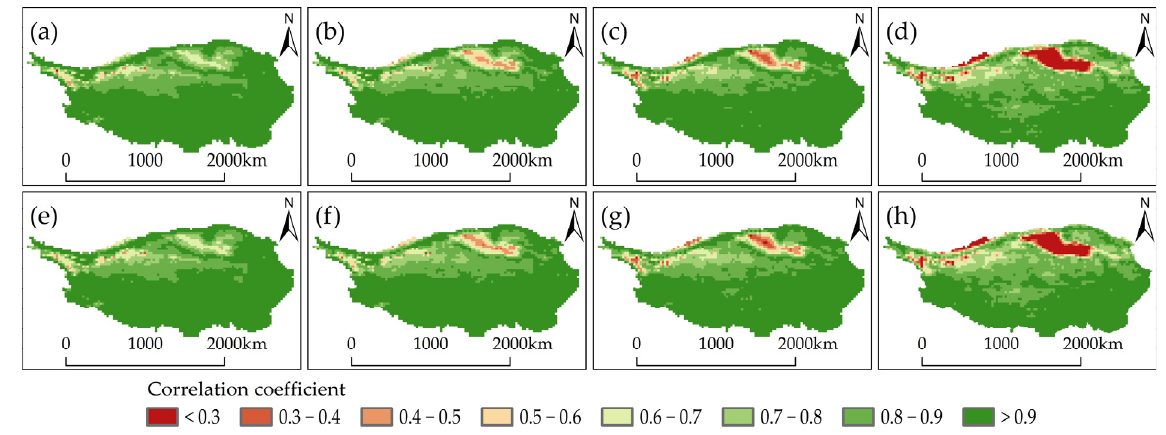
Figure 14. Correlations of three drought indices under different climate scenarios: PA index and SPEI index correlation under the ( a ) RCP2.6, ( b ) RCP4.5, ( c ) RCP6.0, and ( d ) RCP8.5 climate scenarios; SPI index and SPEI index correlation under ( e ) RCP2.6, ( f ) RCP4.5, ( g ) RCP6.0, and ( h ) RCP8.5.